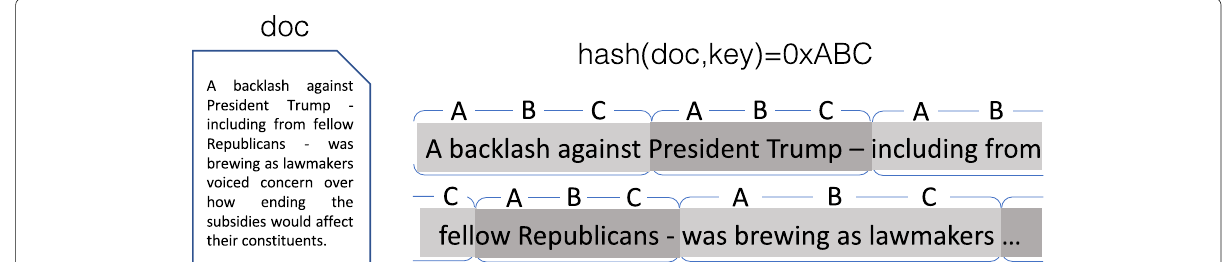
Fig. 4 Fine-grain watermarking. The watermark, computed as the hash of the document and the secret key, is repeatedly embedded in smaller portions of text. For simplicity, a 12-bit watermark is shown, corresponding to the hexadecimal value 0xABC . Watermarked portions are alternately highlighted